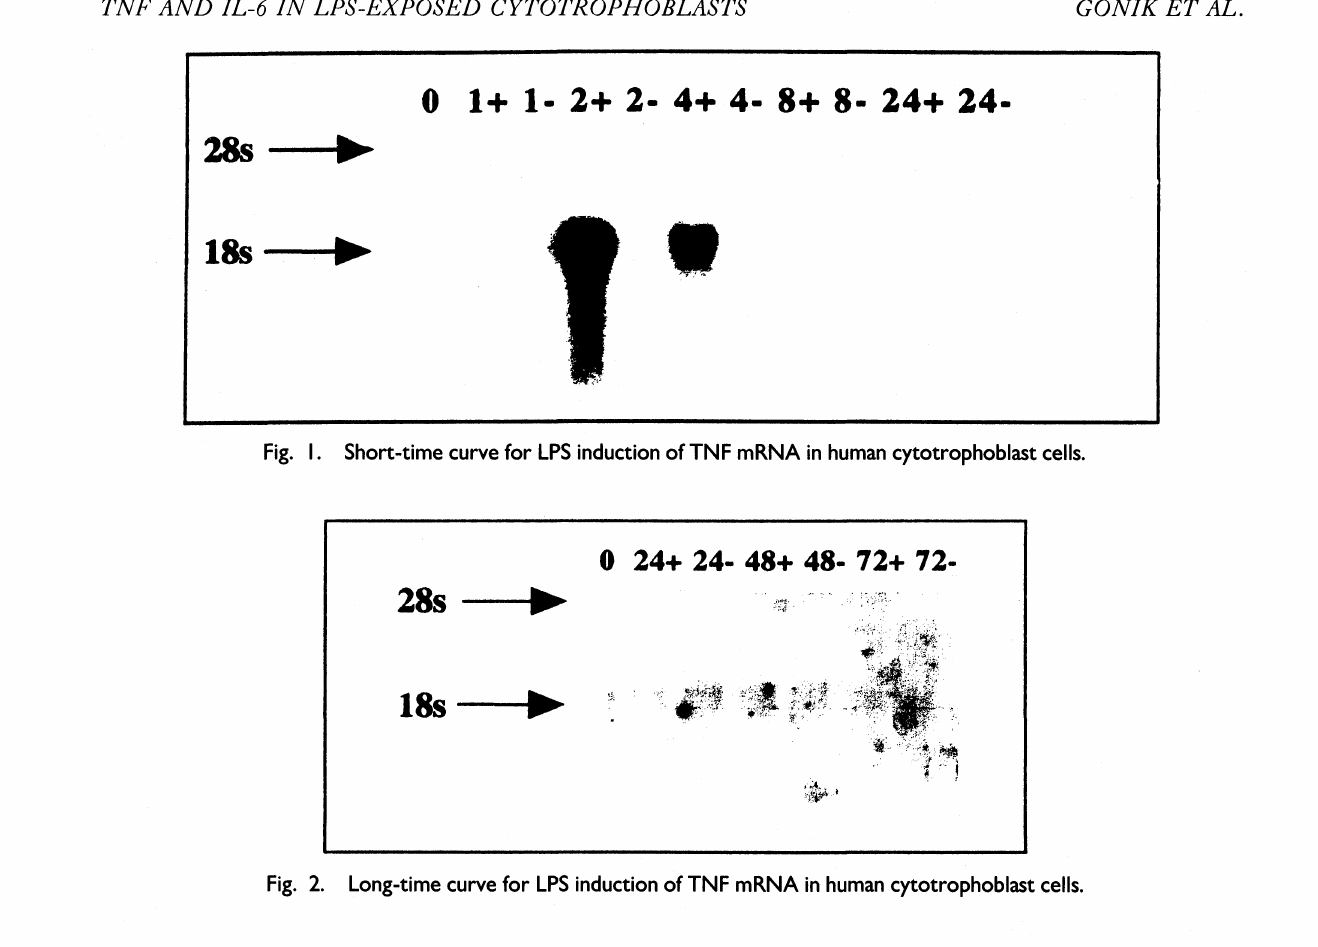
Long-time curve for LPS induction of TNF mRNA in human cytotrophoblast